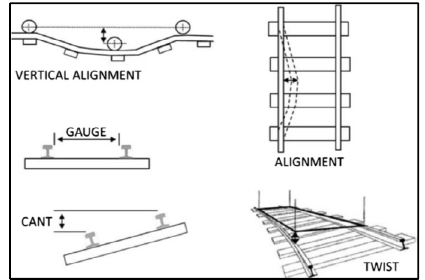
Figure 2. Track quality parameters—adapted from [4] .